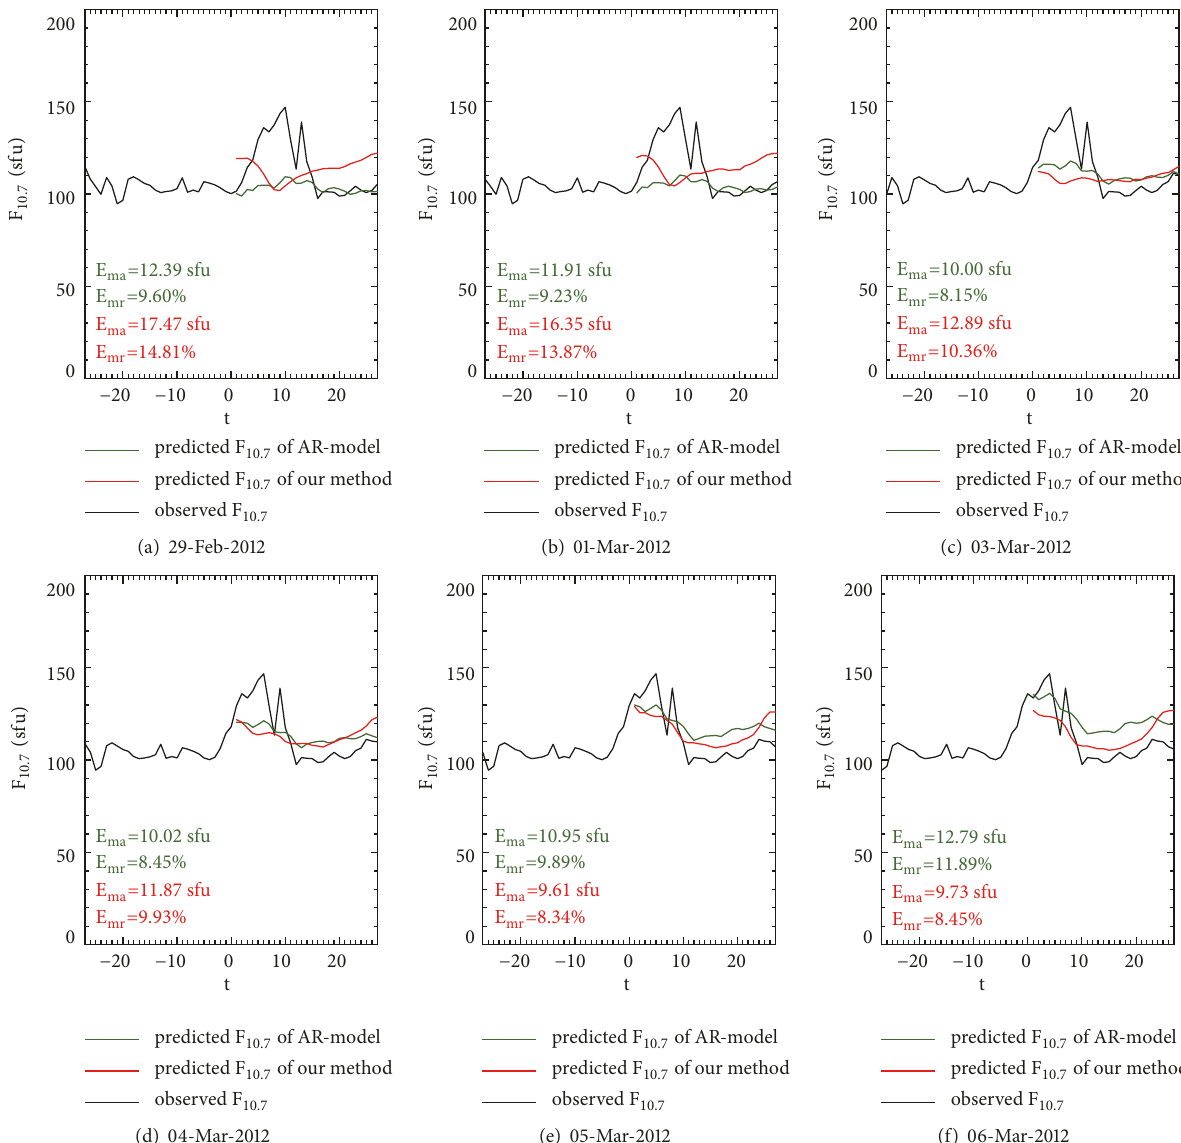
Figure 13: A comparison of observed F 10.7 (black line) and predictive F 10.7 obtained from AR-model (green line) and our method (red line) from 29 February 2012 to 6 March